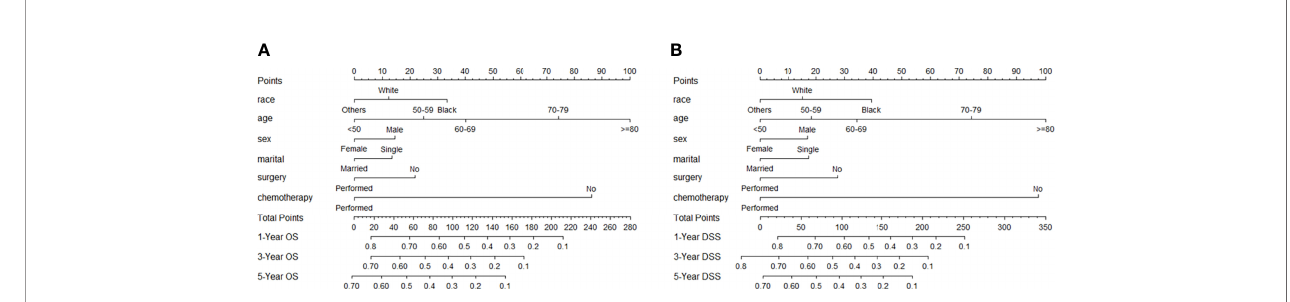
FIGURE 5 | Nomogram to predict 1-, 3-, and 5-year OS (A) and DSS (B) probability in patients with primary central nervous system lymphoma. The OS and DSS rates at 1, 3, and 5 years can be predicted by integrating scores related to race, age, sex, marital status, surgery, and chemotherapy and projecting the total points to the bottom